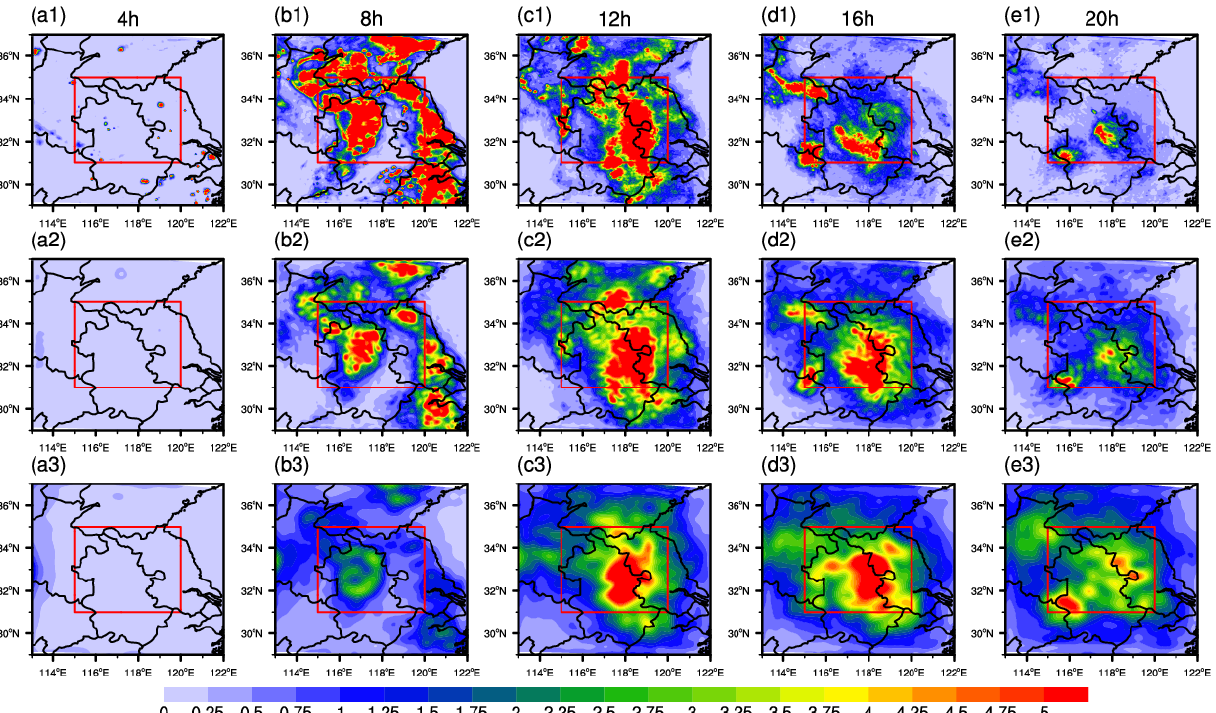
Figure 12. As in Fig. 11, but in the WF case. The red square marks the major precipitation